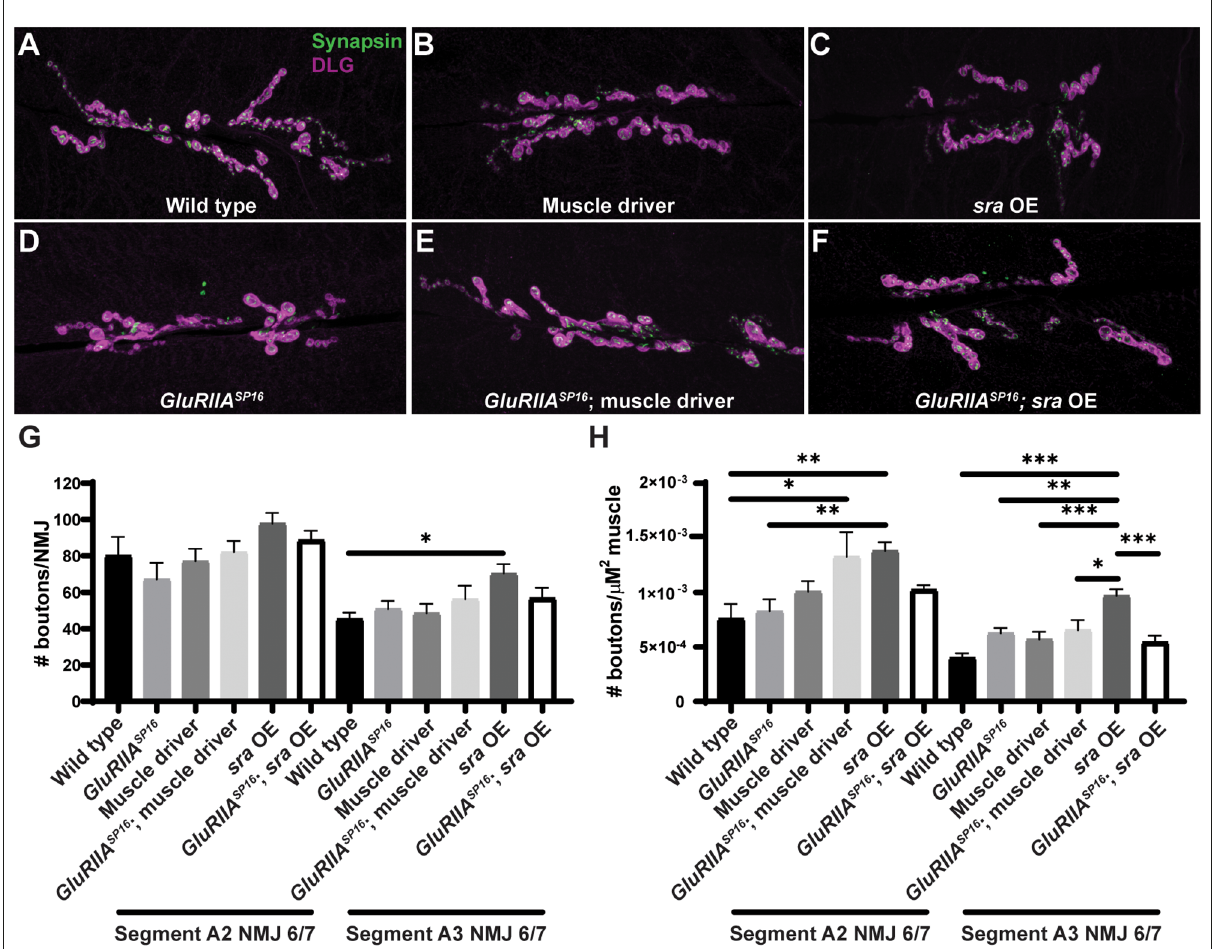
FIGURE5 Postsynaptic sra overexpression does not impair synapse development. (A–F) NMJs were co-stained with anti-DLG (magenta) and anti-Synapsin antibodies (green) to visualize synaptic boutons. (G) NMJ growth was assessed by bouton counting at abdominal segments A2 and A3, muscle 6/7, based on postsynaptic DLG staining and checking for presynaptic Synapsin. (H) Bouton counts were normalized per unit of muscle 6/7 area. Ordinary one-way ANOVAs were used to compare each genotype within each segment followed by a Tukey’s HSD test for multiple comparisons. ∗ p < 0.05, ∗∗ p < 0.01, ∗∗∗ p < 0.001. NMJ, neuromuscular junction; DLG, discs